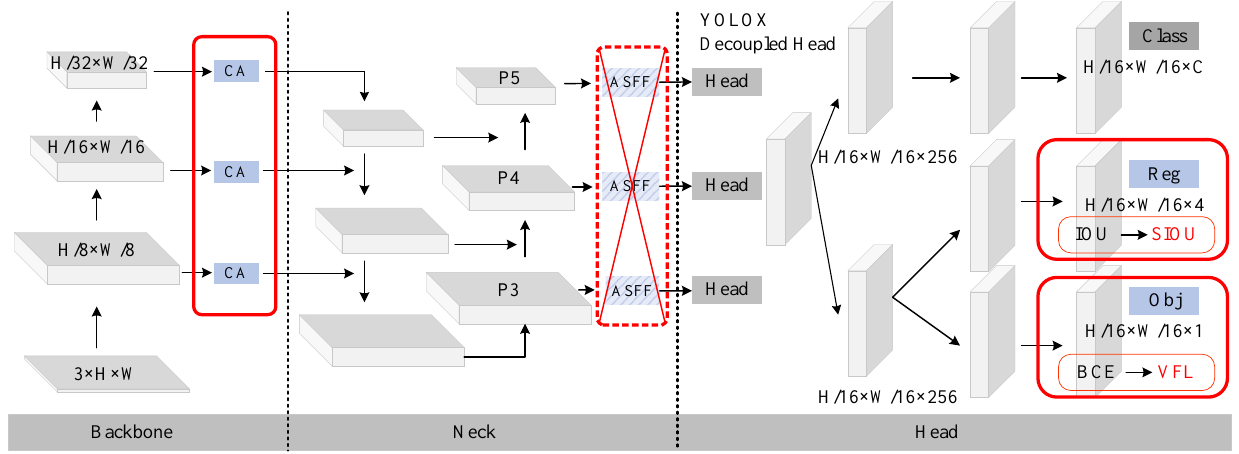
Figure 7. The structure of the improved YOLOX.